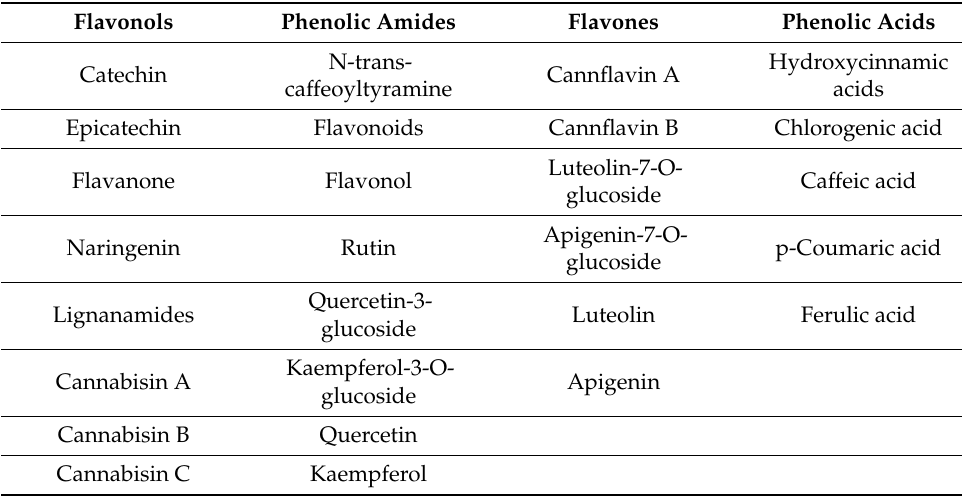
Table 4. List of phenolic compounds in commercial Cannabis sativa L. [34]. Flavonols Phenolic Amides Flavones Phenolic Acids Hydroxycinnamic N-trans- Cannflavin A Catechin caffeoyltyramine